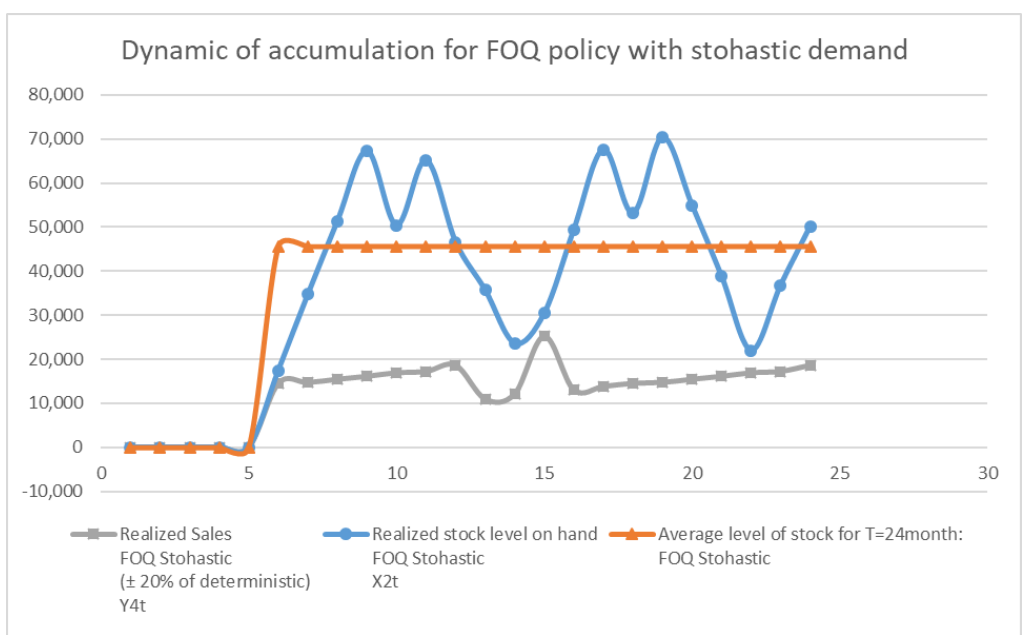
Figure 9. Dynamic of accumulation for Case 2: FOQ policy with stochastic